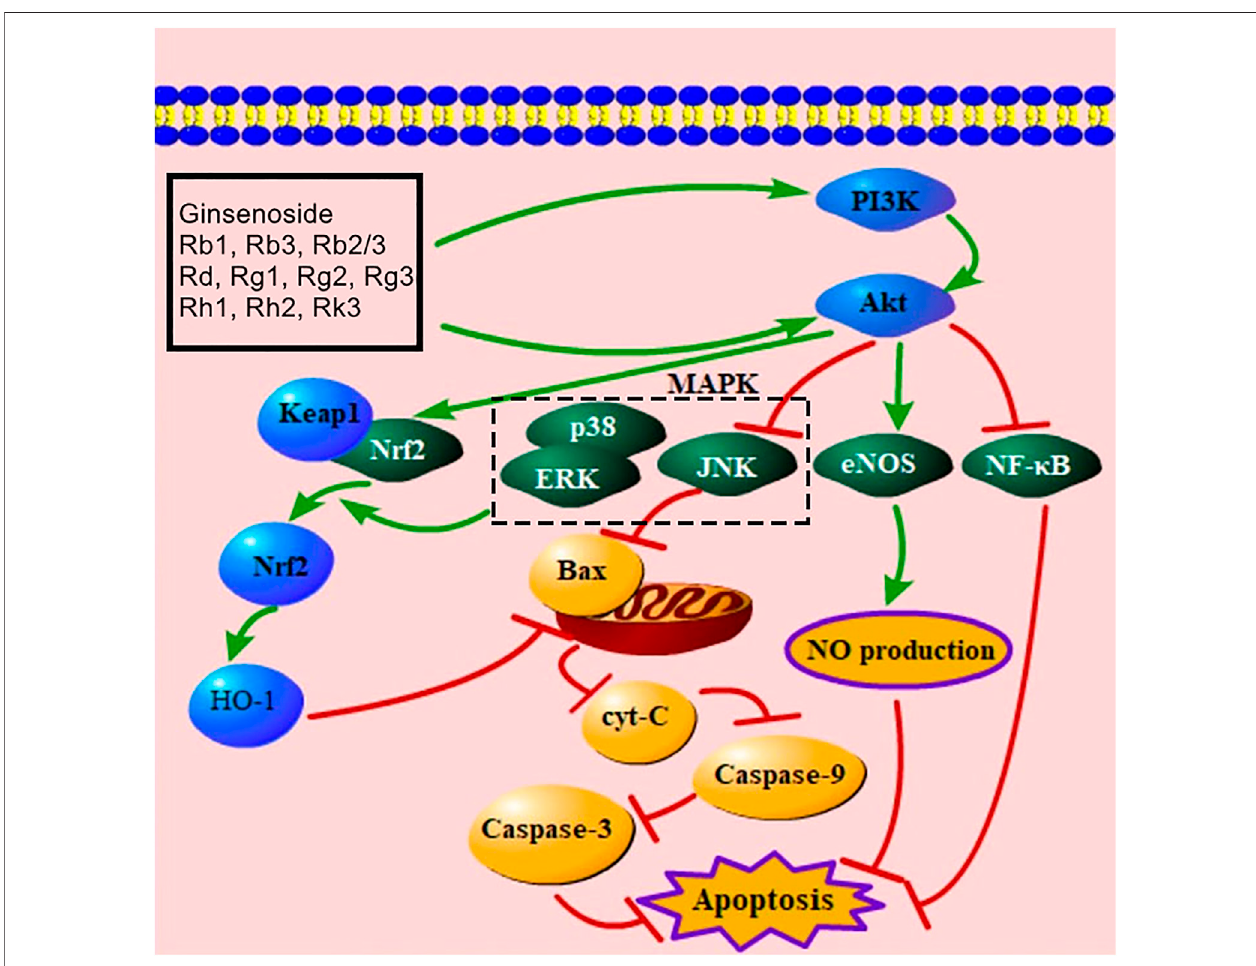
FIGURE5| PI3K/Akt-mediatedsignalingpathwayofginsenosideinrelievingMCapoptosis.PI3K,phosphatidylinositol-3-kinase;MAPK,mitogen-activatedprotein kinase;Keap1,Kelch-likeECH-associatedprotein1;Nrf2,nuclearfactorE2 – relatedfactor2;HO-1,hemeoxygenase-1;ERK,extracellularsignal – regulatedkinase;Cyt- C, cytochrome C; eNOS, endothelial nitric oxide synthase; NF- κ B, nuclear factor of kappaB; NO, nitric oxide.